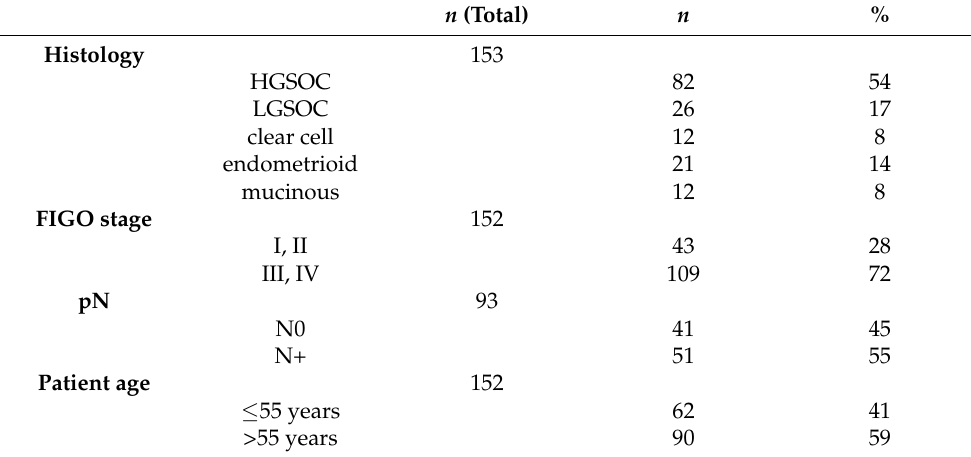
Abbreviations: HGSOC—high-grade serous ovarian cancer, LGSOC—low-grade serous ovarian cancer, pN— pathological lymph node status (N0: no lymph node metastasis detected, N+: lymph node